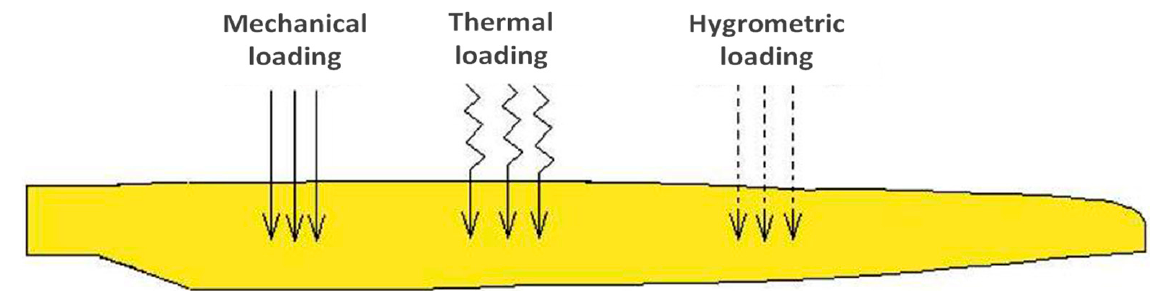
Figure 1. Blade subjected to a hygro-thermomechanical loading [7].